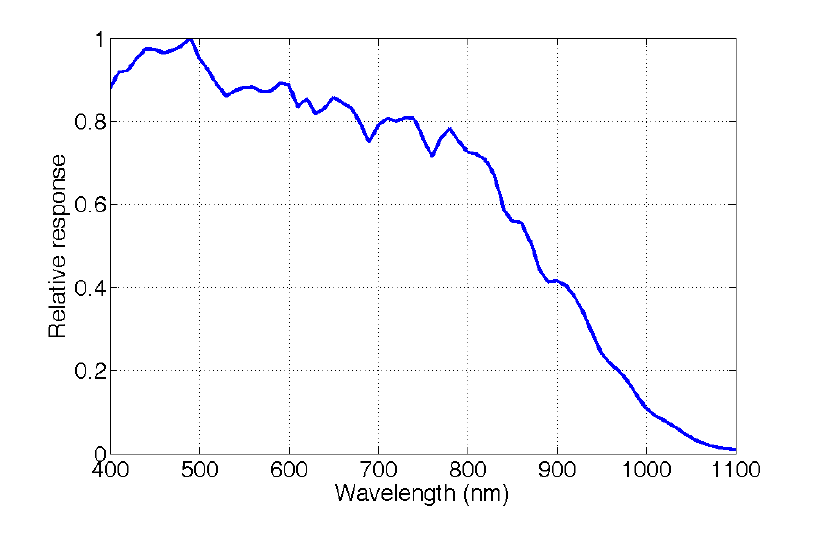
Figure 9. Relative response of the e2v EV76C661ABT sensor [88]. The measurements were done using the OL Series 750 Spectroradiometric Measurement System [89] with a tungsten